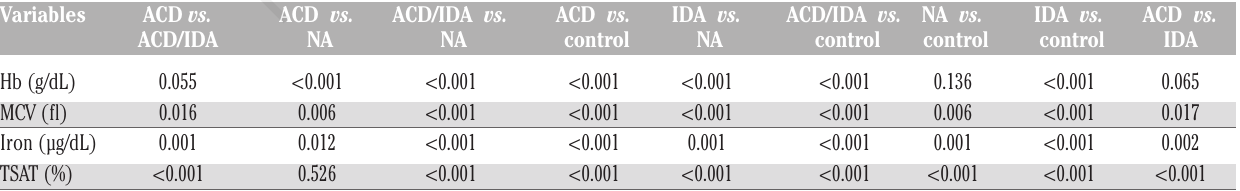
Table 2. Comparison of the hematological parameters and iron status in the study population (P value). Variables